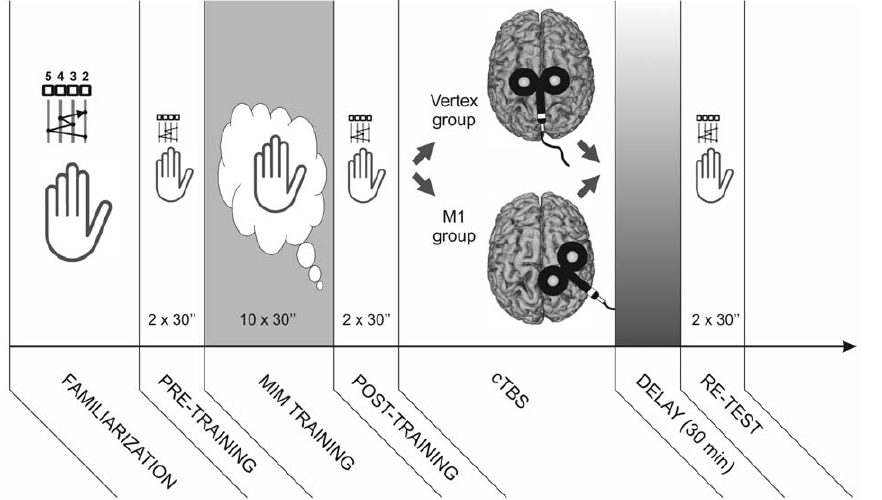
Figure 2. Schematic view of Experiment # 2 protocol. The experiment was the same as that undergone by subjects from the MIM group in Experiment # 1 except that, after the post-training session, cTBS was applied either over the contralateral (right) primary motor cortex (M1) in a group of 8 subjects or over the vertex in another group of 8 controls subjects.